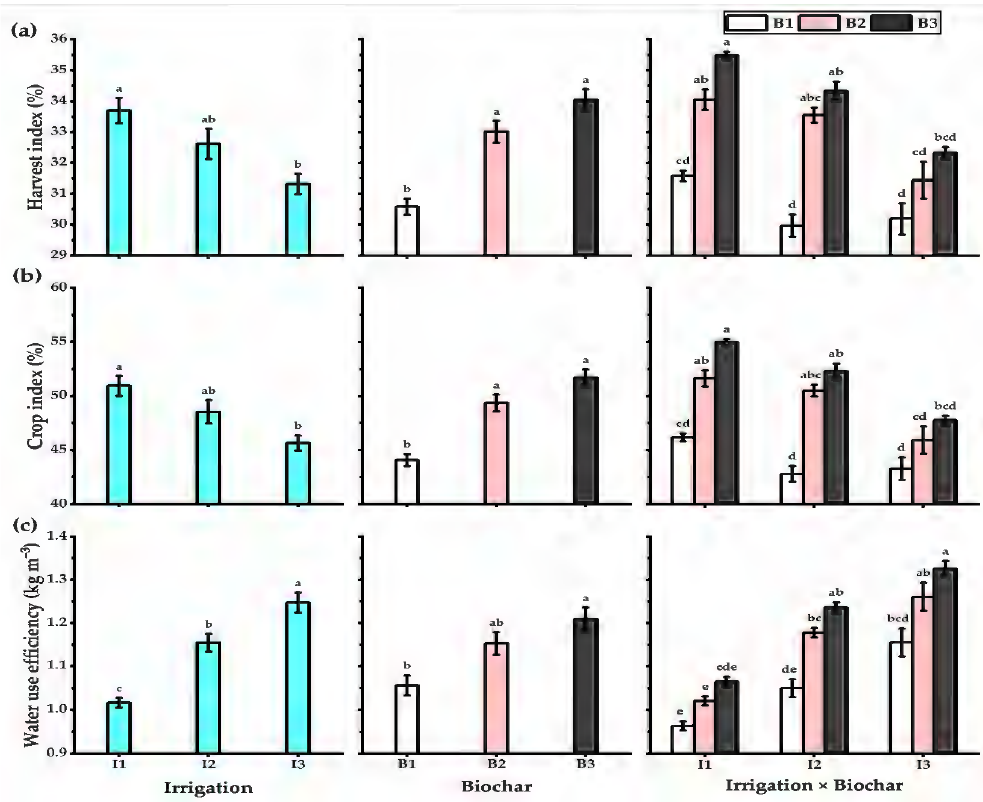
Figure 4. ( a ) Harvest index (%), ( b ) crop index (%), and ( c ) water use efficiency (kg m − 3 ) of the wheat plants affected by three irrigation levels of 100 (I1), 80 (I2), and 60% (I3) of crop evapotranspiration (ETc), and three levels of biochar soil supplementation, 0 (B 1 ), 7.5 (B 2 ), and 15 t ha − 1 (B 3 ). Bars and error bars represent the means ± SE, respectively, of three biological replicates. Different letters reveal statistically significant differences among